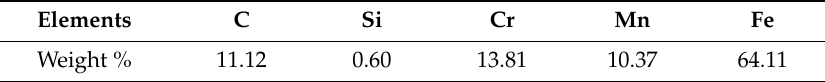
Table 11. Elements present in fracture face of TIG weld zone.